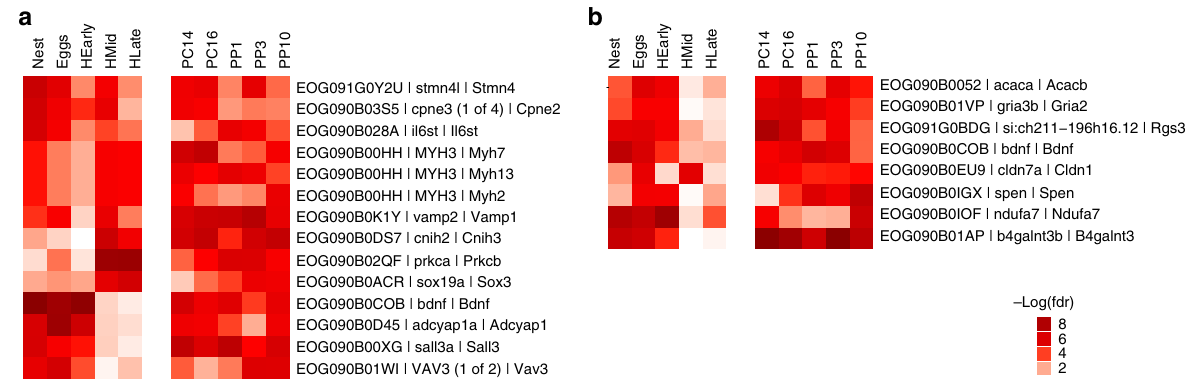
Fig. 3 DEGs associated with shared orthogroups. Color represents the signi fi cance of differential expression between the control and experimental group ( p values ( − log(fdr)) across the fi ve conditions in stickleback (left) and the fi ve conditions in mouse (right). a shows the signi fi cance of DEGs within 14 shared orthogroups between diencephalon in stickleback and hypothalamus in mouse. b shows the signi fi cance of DEGs within nine shared orthogroups between telencephalon in stickleback and hippocampus in mouse. Source data are in GEO GSE134508